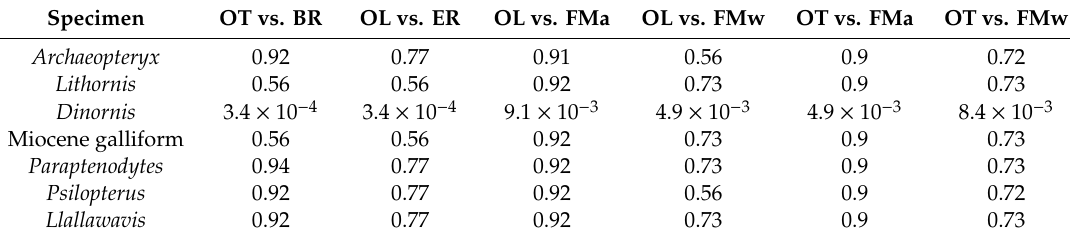
Table 6. Resulting p -values of the phylogenetic ANCOVA comparing the intercept of each extinct member of the sample to the intercept of the rest of the sample, given a common slope, with the outlier Apteryx excluded. These p -values have been adjusted with the Benjamini and Hochberg [89] procedure to control for false discovery rate; unadjusted p -values are available in Table S3. Significant di ff erences are highlighted in aqua. Abbreviations: BR, brain-remainder volume (brain volume minus optic-tectum volume); ER, endocast-remainder surface area (endocast surface area minus optic-lobe surface area); FMa, foramen-magnum area; FMw, foramen-magnum width; OL, optic-lobe surface area; OT, optic-tectum volume.